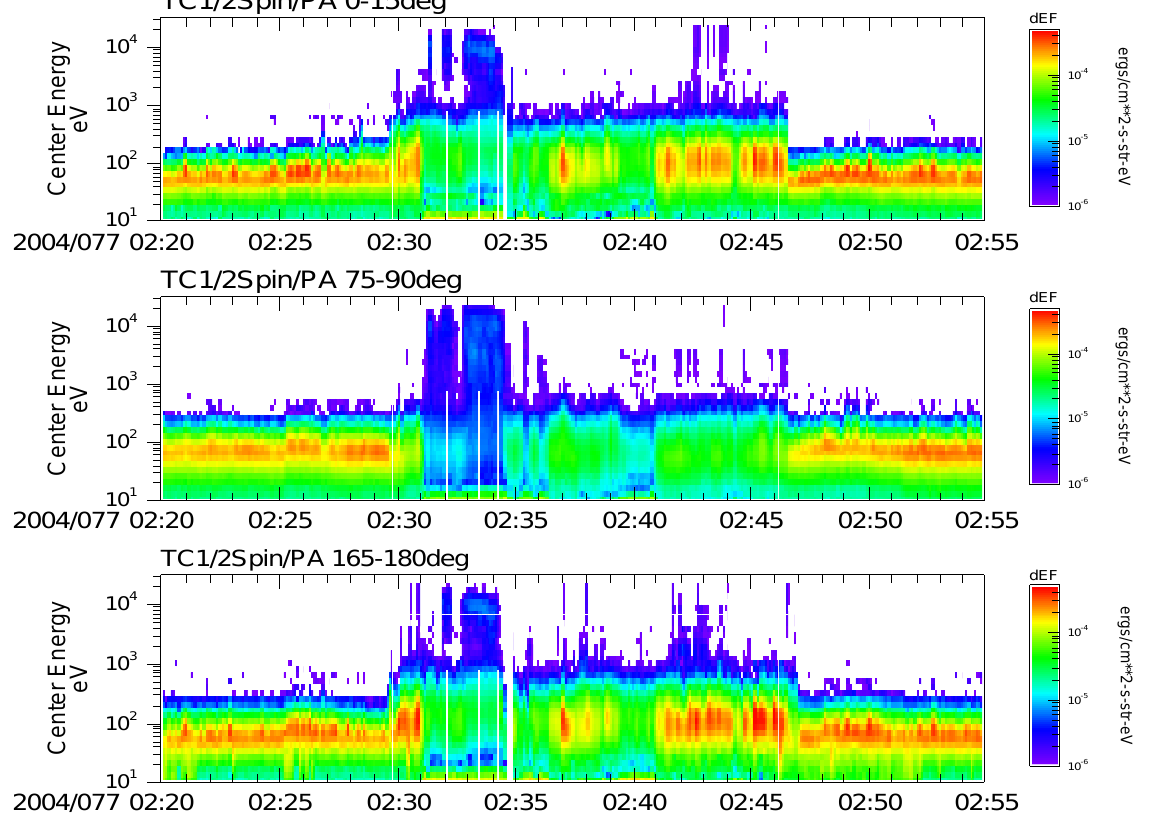
Fig. 5. Time-energy spectrogram of low energy electrons from TC-1. From top to bottom, are electron energy fluxes in the pitch angle range of 0–15 ◦ , 75–90 ◦ and 165–189 ◦ ,